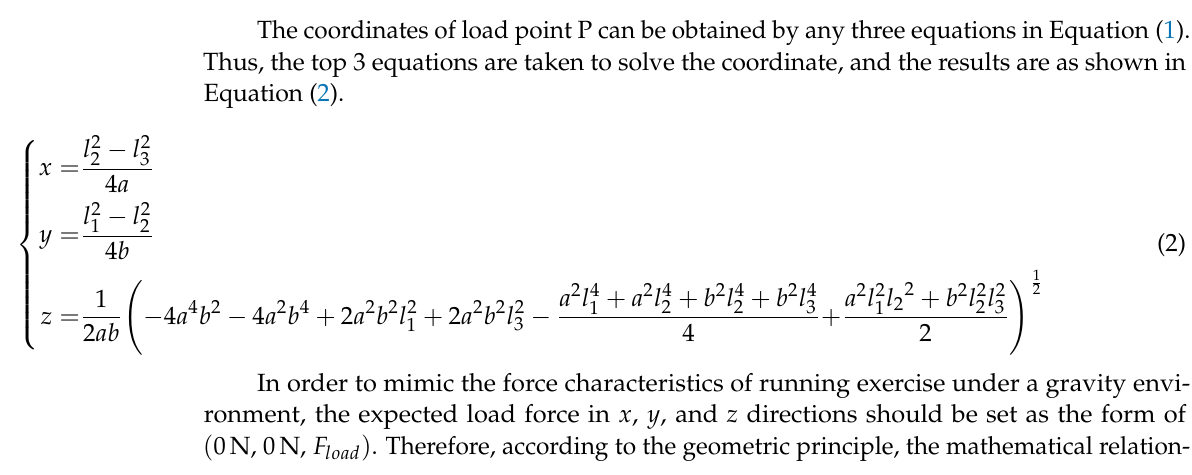
Figure 4. Force analysis diagram of running